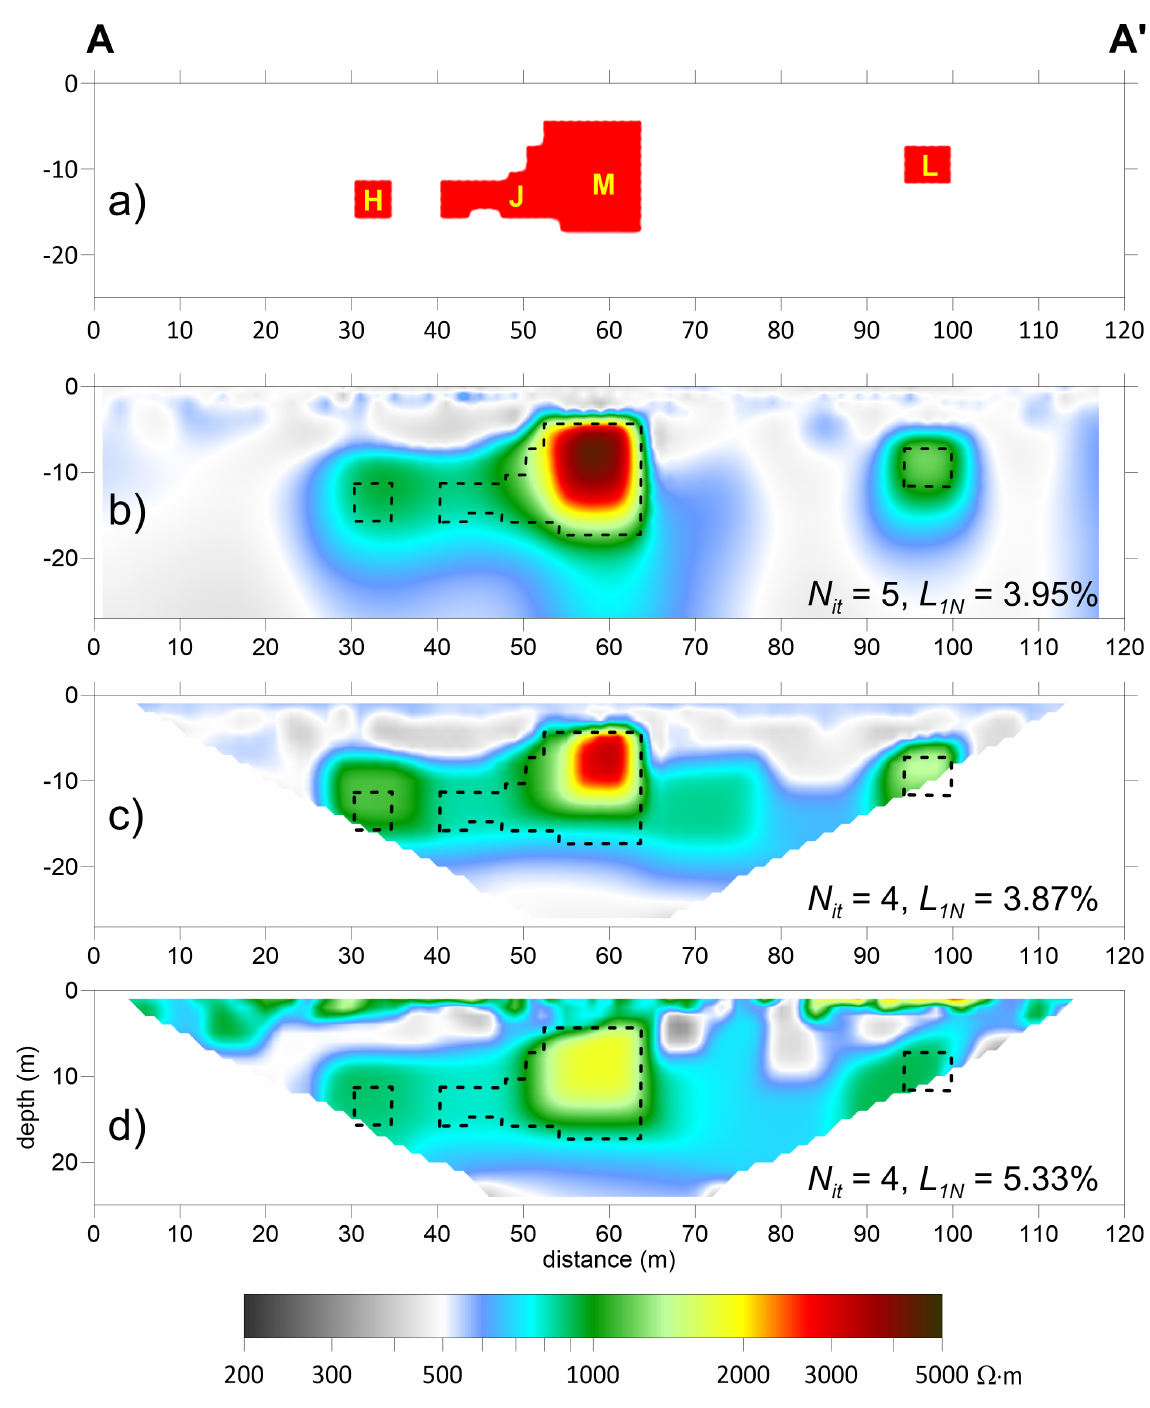
Figure 12. Line A − A’ comparison between simulated inversion of 3D and 2D resistivity surveys and 2D inversion of field data. ( a ) Corresponding section of the 3D resistivity model. ( b ) Vertical section of the inverse model obtained by simulating a 3D survey on the geophysical model. ( c ) Inverse model obtained by simulating a 2D survey on the geophysical model. ( d ) Inverse model obtained by 2D ERT field